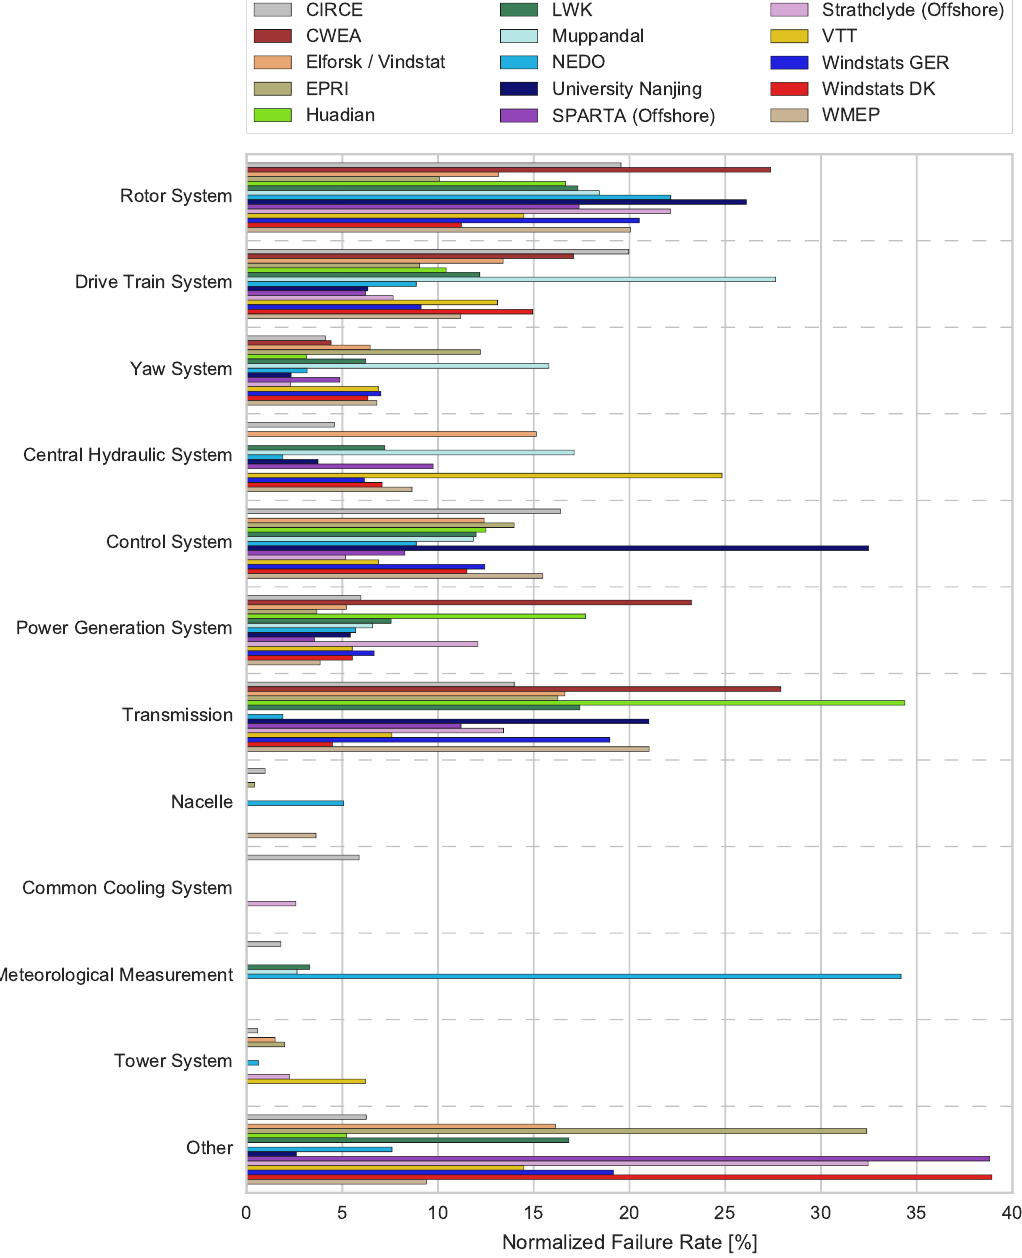
Figure 7. Normalized failure rates per system as published by different